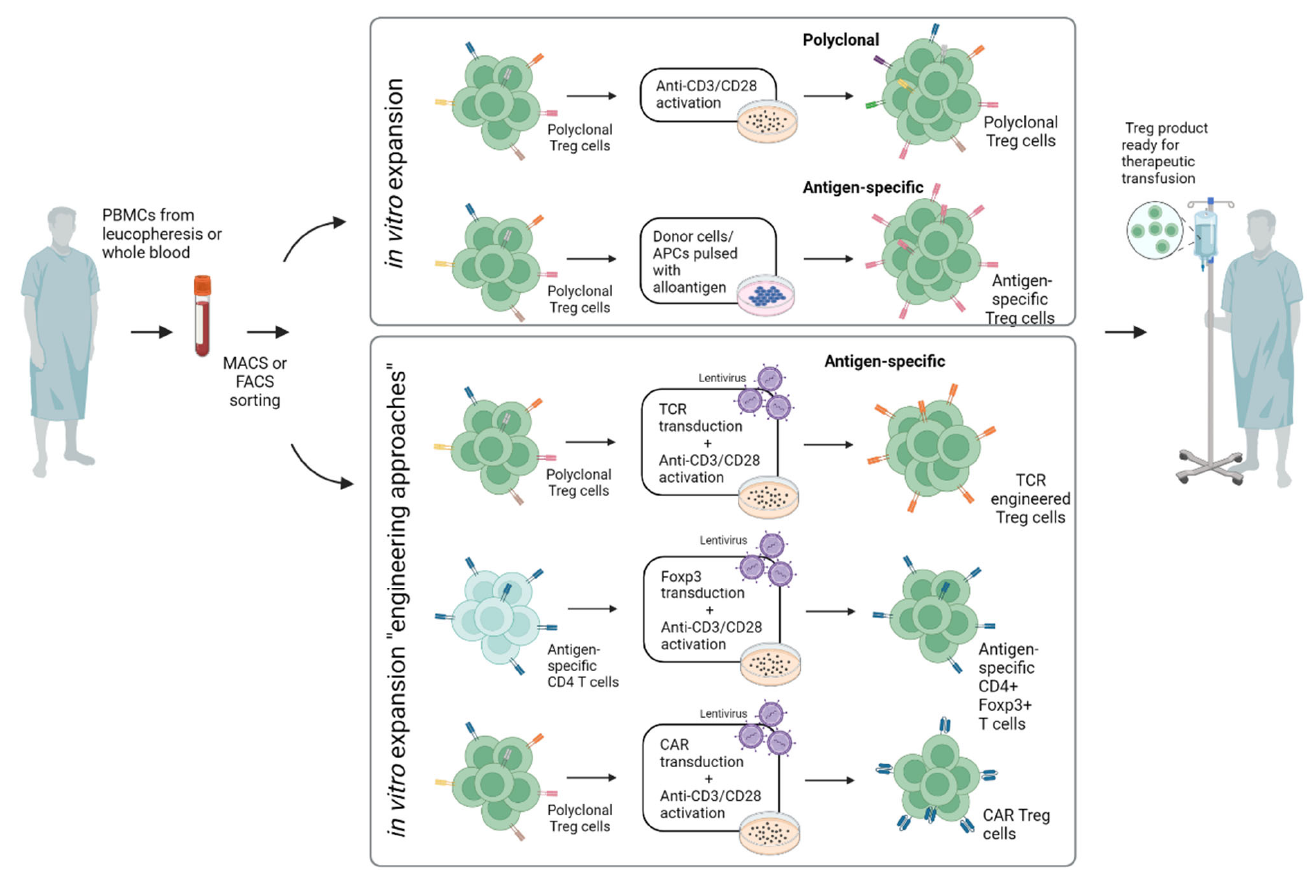
Figure 2. Different approaches for in vitro expansion of Tregs. Engineering approaches are supposed to increase specificity and feasibility. PBMCs: peripheral blood mononuclear cells; FACS: fluorescence-activated cell sorting; MACS: magnetic-activated cell sorting; APC: antigen-presenting cell; TCR: T cell receptor; CAR: chimeric antigen receptor (created with biorender.com).